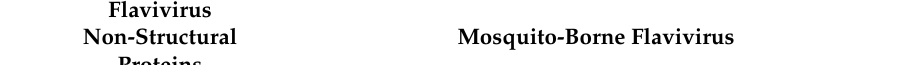
Table 1. Functions of flaviviral non-structural proteins implicated in viral persistence. Flavivirus non-structural proteins are summarized as they appear in the text. ** Where a function is not indicated for tick-borne flaviviruses (TBFV)s, a similar function is presumed for both tick and mosquito-borne flaviviruses since, in many cases, no detailed research endeavors have been carried out on